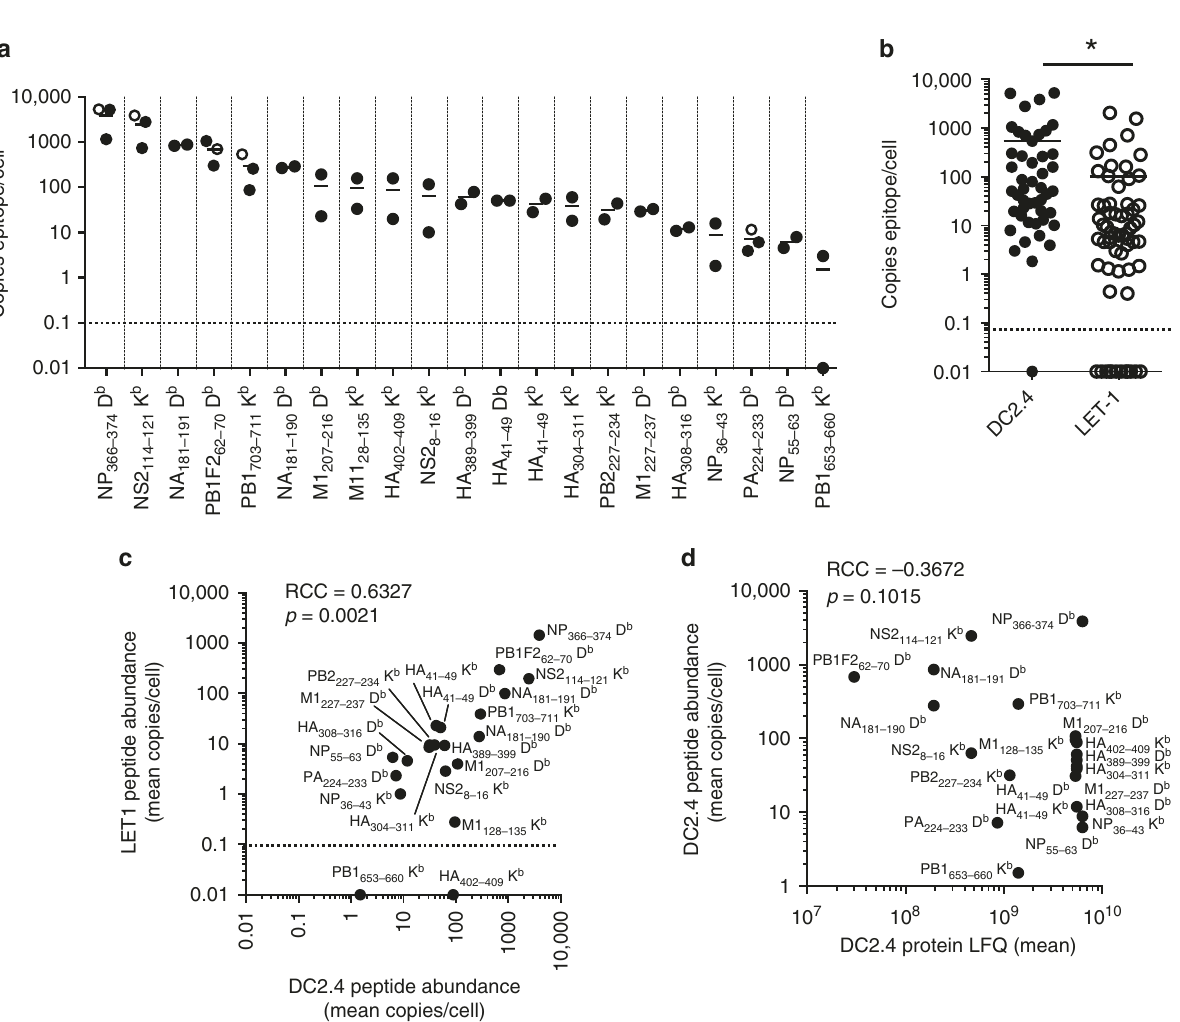
Fig. 1 Detection and quantitation of MHCI-bound IAV peptides following direct infection. DC2.4 cells (1 × 10 8 ) were mock treated or infected for 8 h with the PR8 strain of IAV at an MOI of 5, epitopes were eluted from immunoaf fi nity-puri fi ed K b and D b MHCI molecules and analyzed by LC-MRM. a Absolute quantitation of peptide abundance shown as peptide copies/cell. N = 2 – 3 independent infections are shown. Open circles represent initial quantitation of known epitopes. Closed circles represent quantitation of all epitopes discovered by LC-MS/MS. b Quantitation of peptides eluted from DC2.4 cells and LET1 cells, with each data point representing a single replicate of a particular peptide. N = 2 – 3 independent infections (* p = 0.008 using Mann − Whitney nonparametric test). Correlation between c mean peptide abundance from DC2.4 cells vs. LET1 cells ( N = 3), and d mean peptide vs. relative protein abundance in DC2.4 cells, showing the Spearman ’ s rank correlation coef fi cient (RCC) and associated p values. Dashed lines represent the limit of